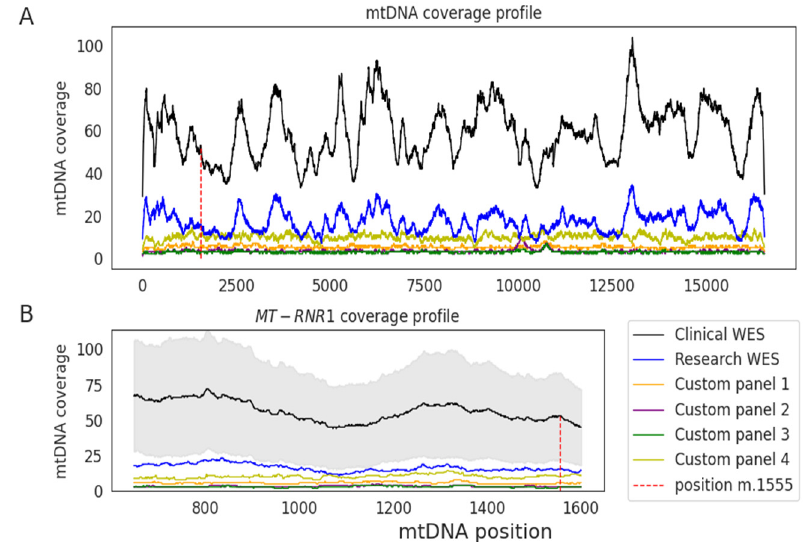
Figure 4. Median read depth across the mitochondrial genome using off-target reads. ( A ) Median coverage is shown for clinical whole-exome sequencing (WES) (black) and for research samples analyzed through WES (blue) or a custom-targeted panel (different colors indicate different sample sets) across each position of the mitochondrial genome. ( B ) Median coverage in the MT-RNR1 gene. Shaded area shows the standard deviation of the clinical WES samples.